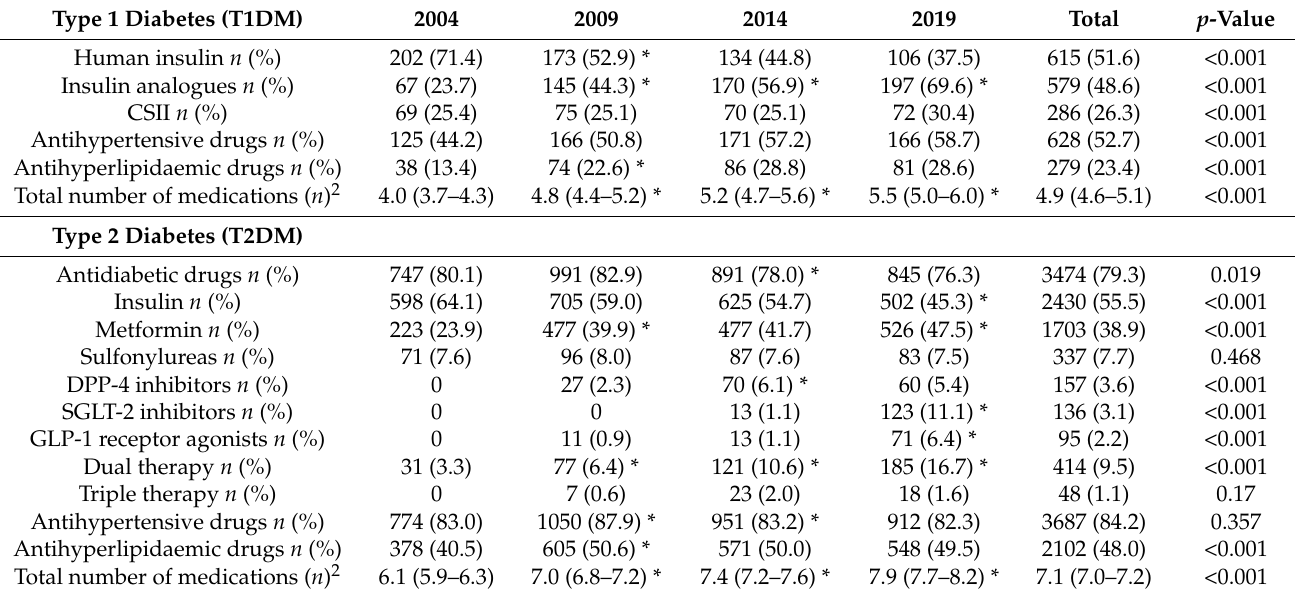
Table 5. Drug therapy of patients in secondary care.